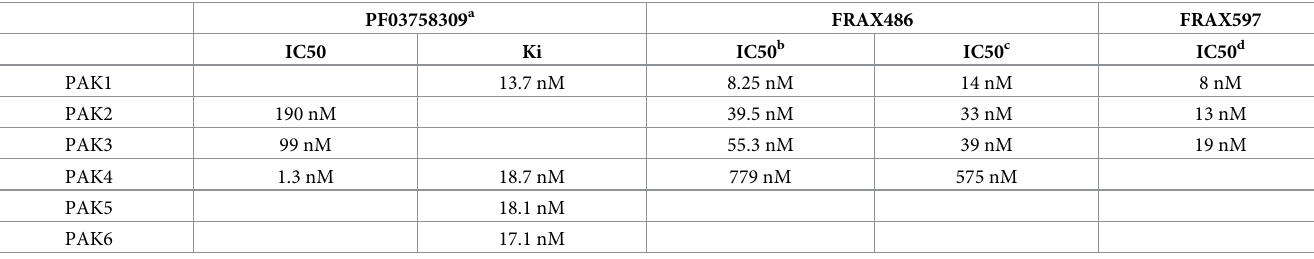
Table 2. In vitro IC 50 and Ki values of PF03758309, FRAX486 and